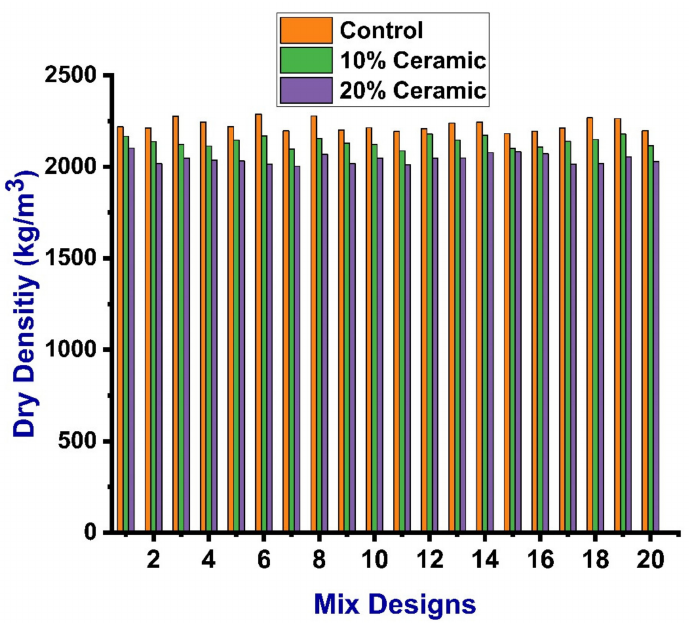
Figure 5. Indicating dry densities of all specimen of each